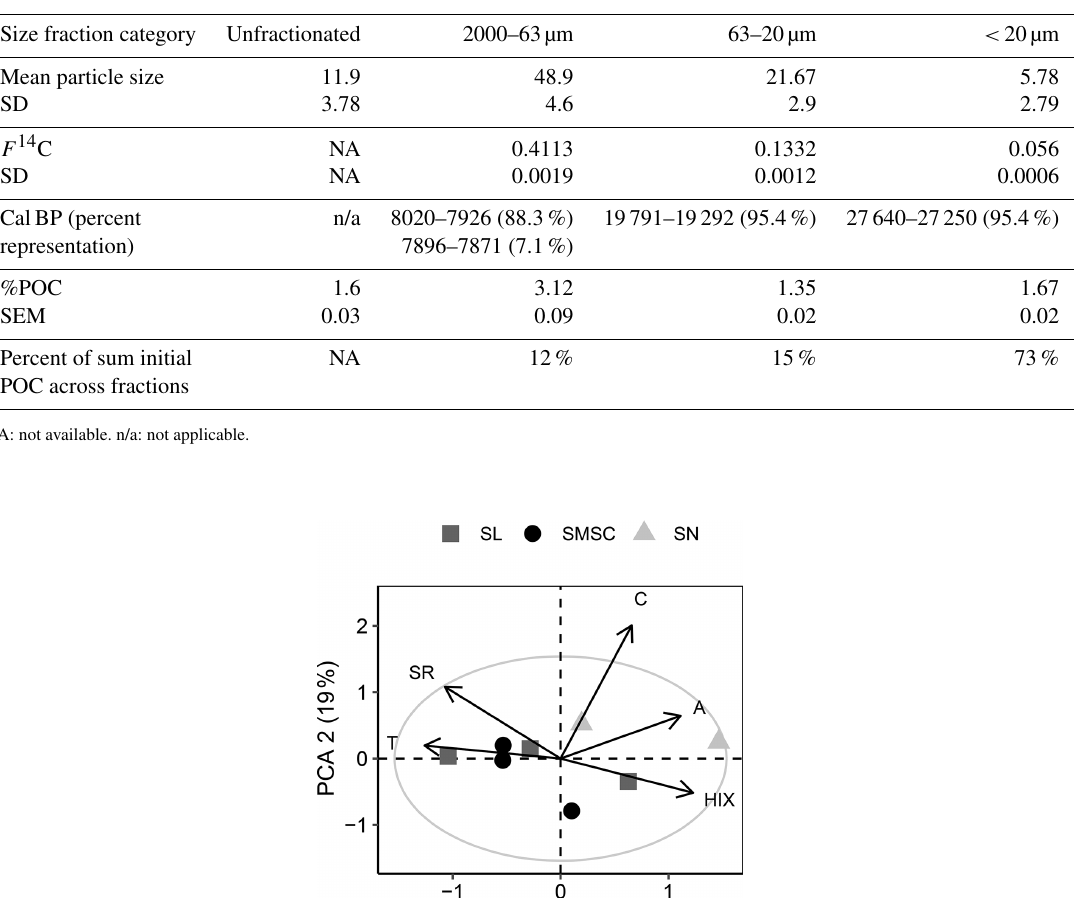
Table B1. Characteristics of size fractions used in 2016 experiment. %POC indicates POC:TSS. SD = standard deviation. SEM = standard error of the mean.